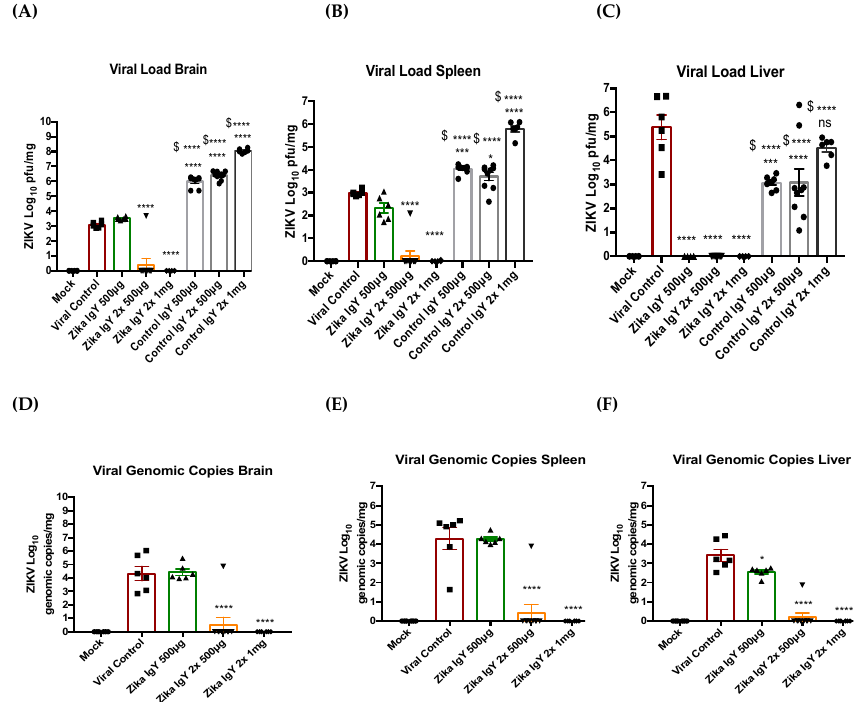
Figure 3. The therapeutic efficacy of anti-ZIKV IgY in vivo: Three-week-old IFNAR − / − mice were administered a lethal dose of ZIKV intravenously (i.v.) in 100 µL total volume. At 24 and 48 h postinfection, the mice were immunized i.p. with the indicated amount of antibody in a volume of 100 µL. The control mice were treated with 100 uL of PBS. ( A , B ) The survival outcome of the treatments and ( C , D ) the weights were monitored daily until day 14 or until morbid. The weights were reported as a percent of the starting weight; the p -values are denoted when comparing the groups to the viral control. ** p < 0.01, *** p < 0.005, and **** p < 0.0001.